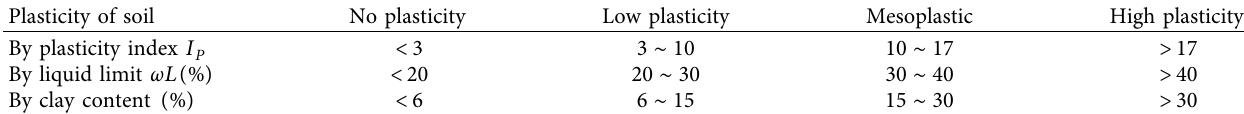
Table 3: Relationship between plasticity degree of general soil and liquid limit clay